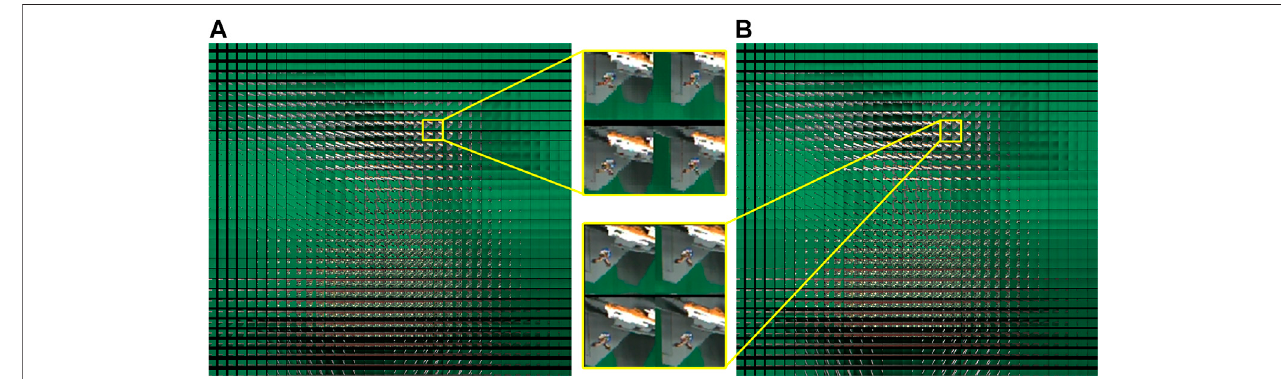
Frontiers in Physics |